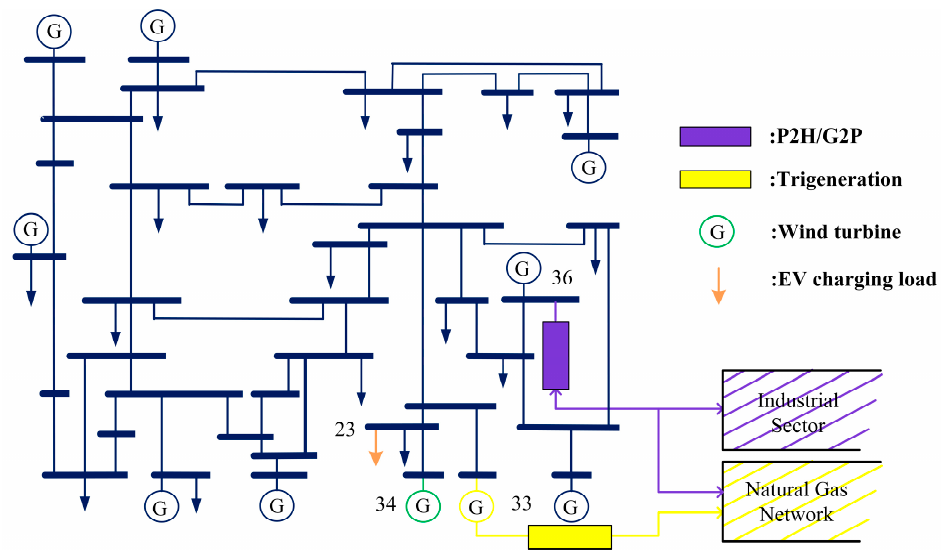
Figure 14. The diagram of the modified IEEE 39-bus case.